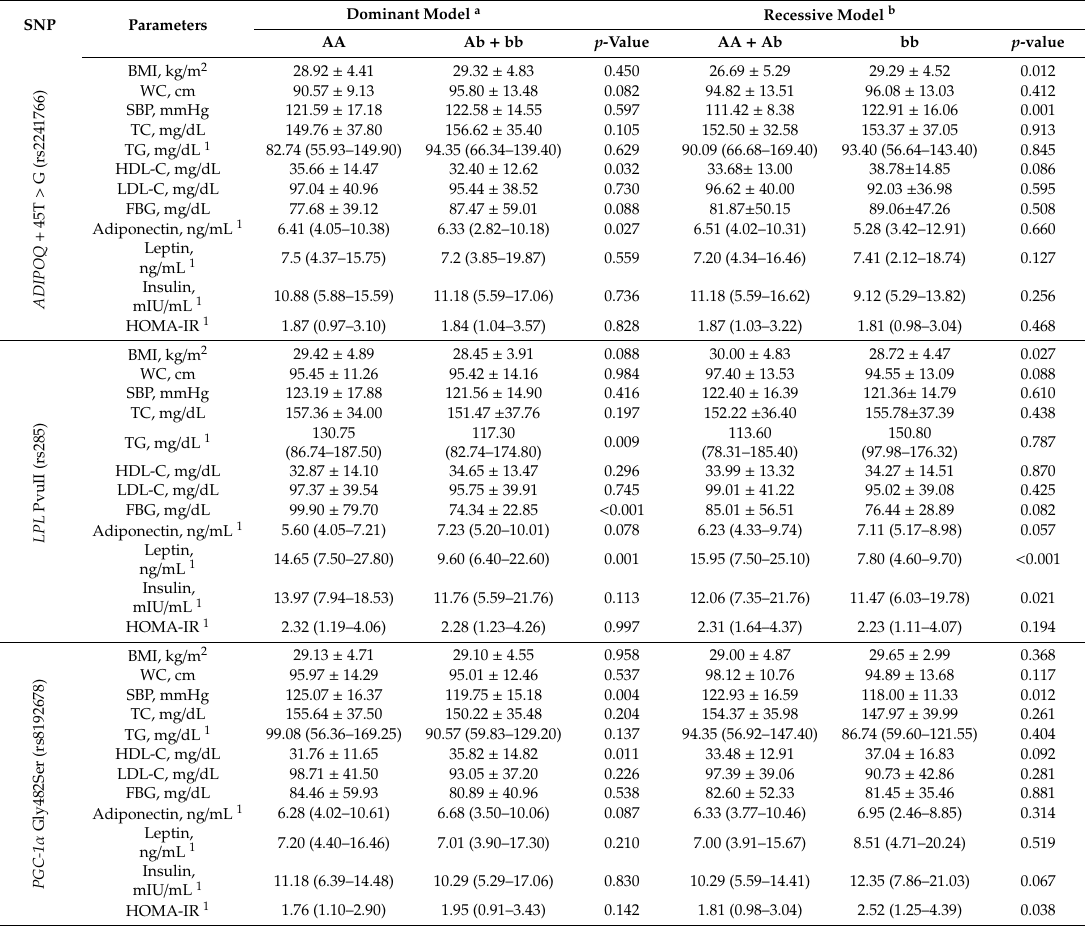
Table 6. Clinical features of subjects according to the genotype of